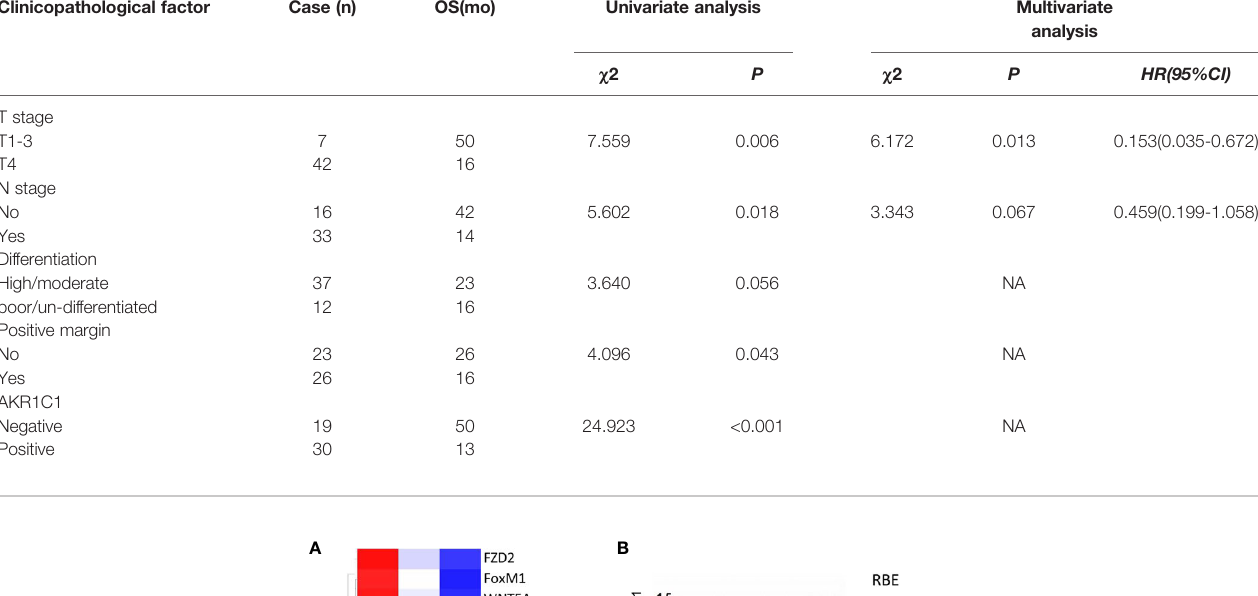
TABLE 3 | Univariate and multivariate analysis of overall survival in 49 patients with hilar cholangiocarcinoma according to clinicopathological factors and AKR1C1 overexpression. Clinicopathological factor